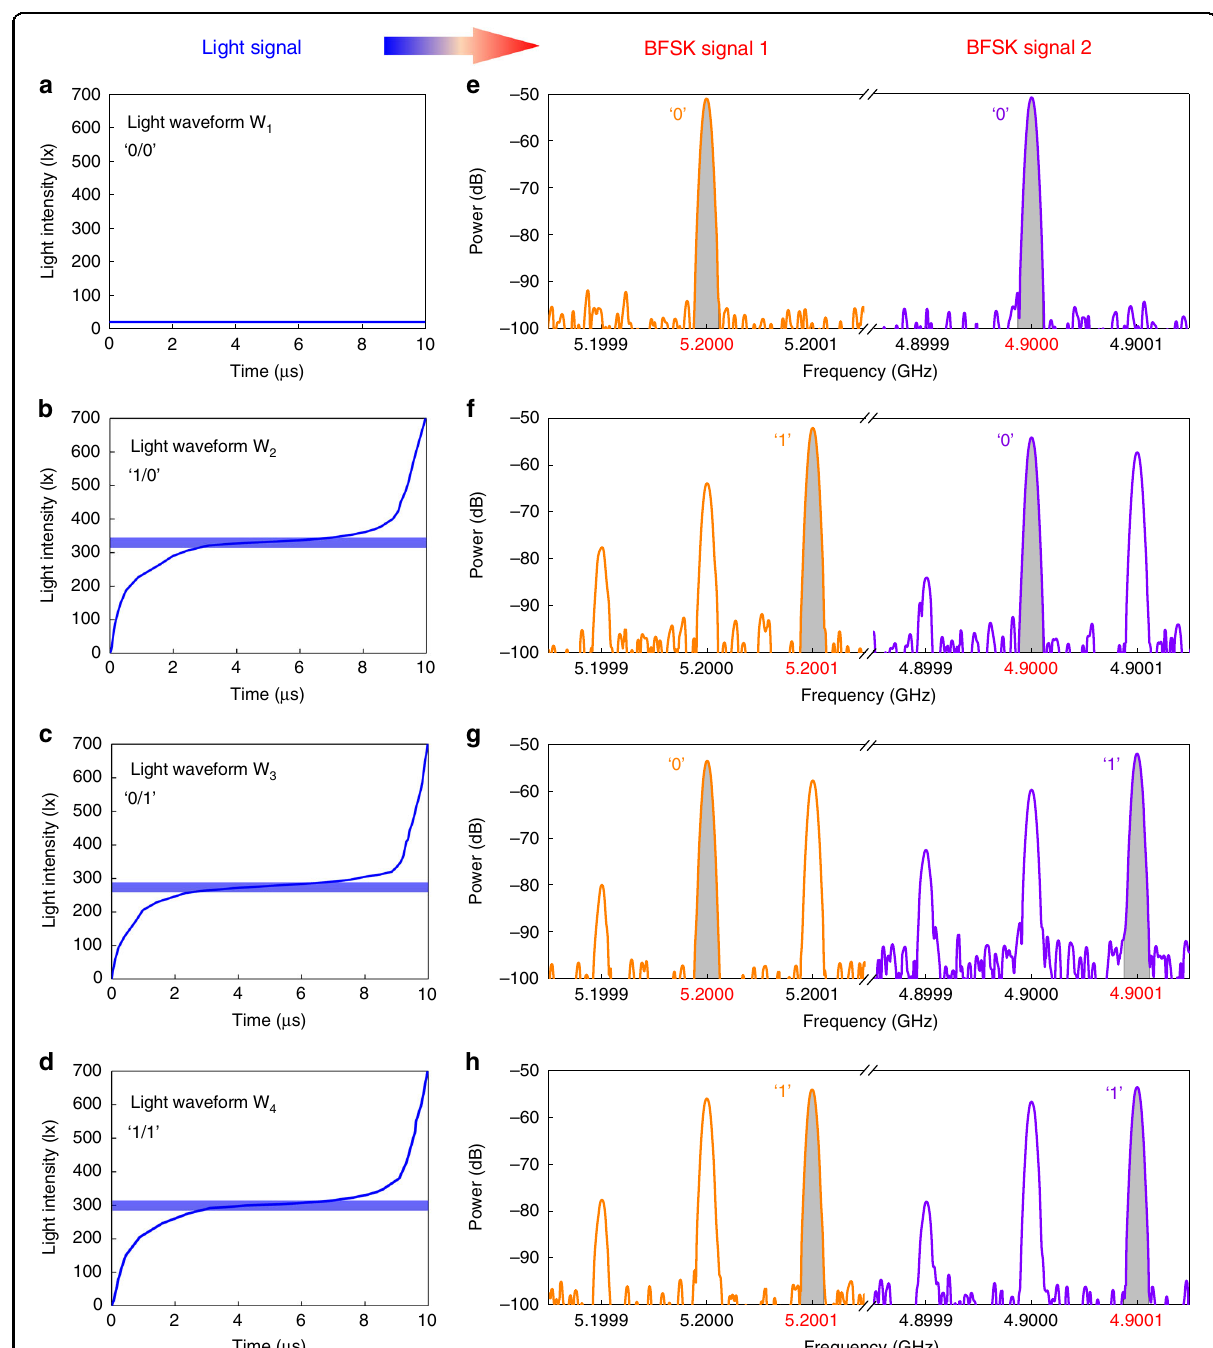
Fig. 3 Process of converting one light signal to two BFSK signals. a – d Four different light waveforms of W 1 ( a ), W 2 ( b ), W 3 ( c ), and W 4 ( d ) in one light signal carry four sets of digital symbols. e – h Measured re fl ection spectral distributions of BFSK signal 1 (left column) and BFSK signal 2 (right column), in which the fundamental frequency and the blue-shifted frequency represent the digital symbols ‘ 0 ’ and ‘ 1 ’ , respectively. When receiving the light waveforms W 1 -W 4 , the generated two BFSK signals are used to transmit ‘ 0/0 ’ ( e ), ‘ 1/0 ’ ( f ), ‘ 0/1 ’ ( g ), and ‘ 1/1 ’ ( h